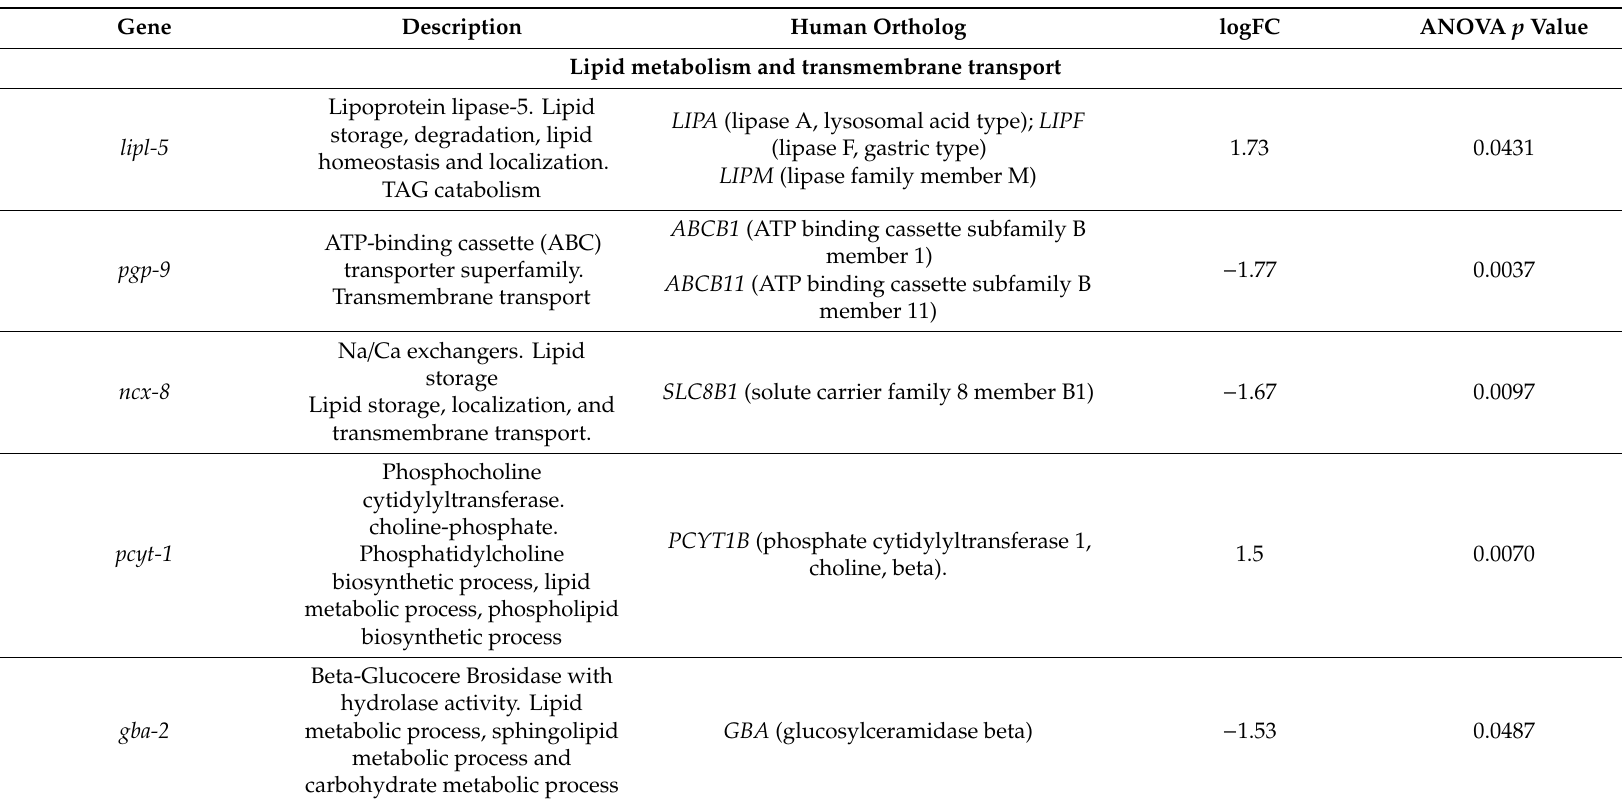
Table 5. Main genes a ff ected after treatment with apigenin (100 µ M) compared with DMSO control